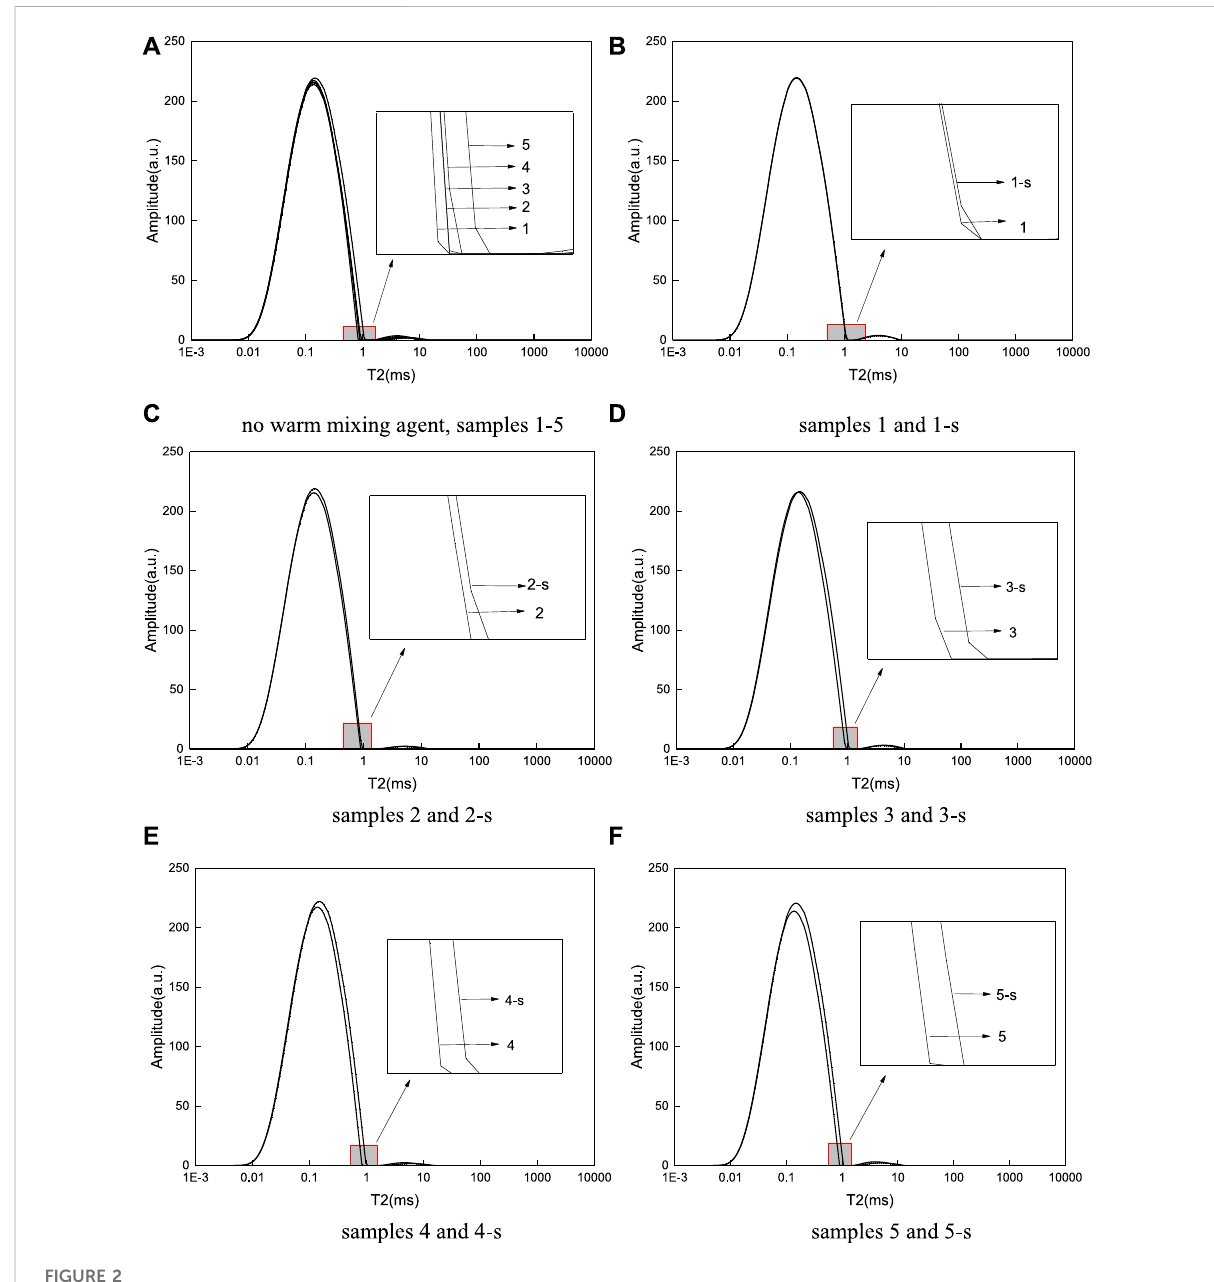
FIGURE 2 LF-NMR spectra of mixed asphalt (cf. Table 3 for